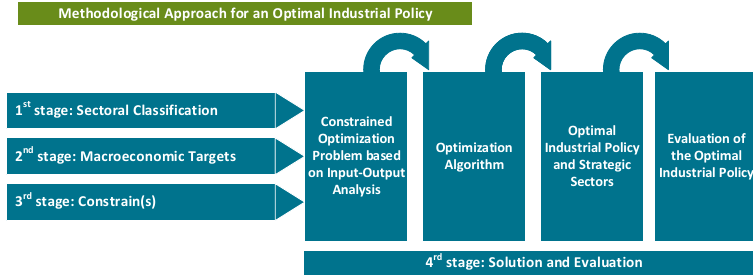
Figure 1. A graphical presentation of the methodological approach.